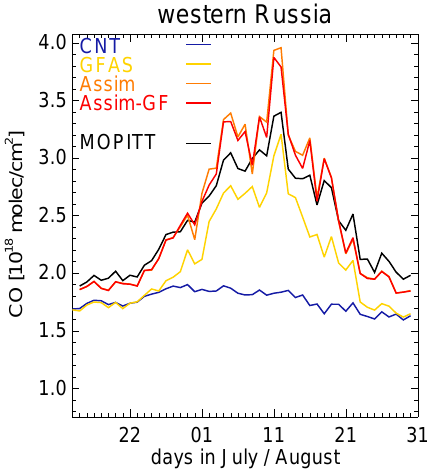
Fig. 6. Evolution of average kernel-weighted total columns over western Russia compared to MOPITT, for D+0